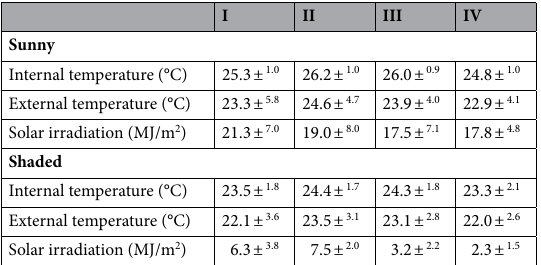
Table 1. Average temperature and irradiance during the first (I), second (II), third (III) and fourth (IV) months of Atta sexdens (Hymenoptera: Formicidae) nests in sunny and shaded environments. Superscripted values represent standard deviation.